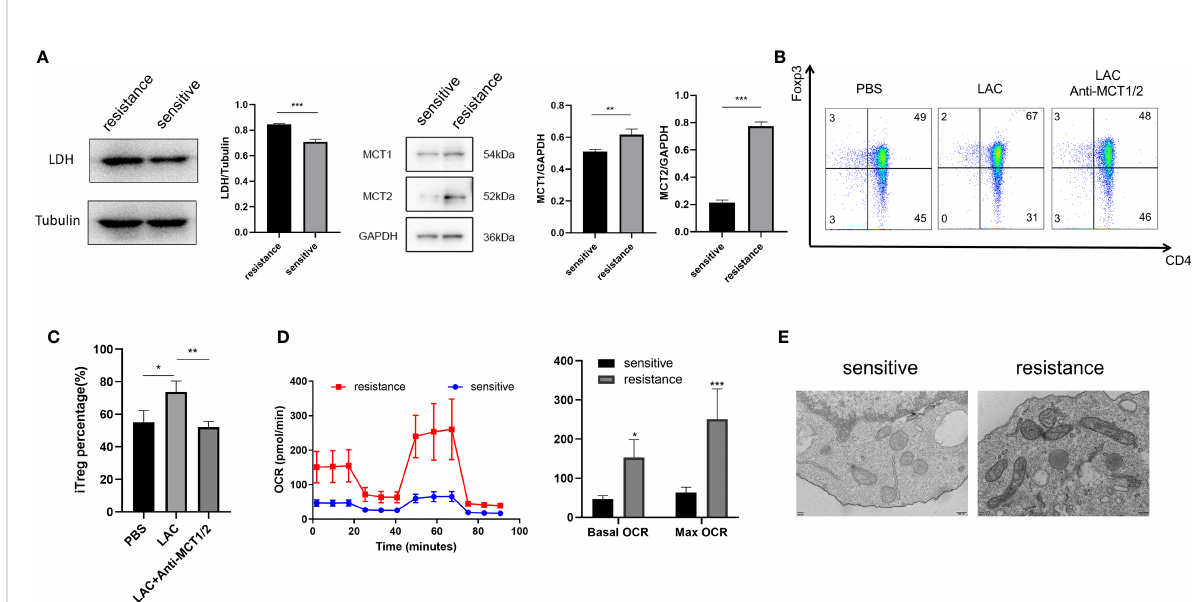
FIGURE 4 Foxp3 was upregulated in the iTregs of the resistant group in an MCT-dependent manner. (A) Representative blot plot for expression of LDH, MCT1, and MCT2 in both groups. Representative fl ow plot (B) for and the frequency (C) of Foxp3 expression in iTregs with the addition of lactate (10 mM) and inhibitors of MCT1 and MCT2 in resistance patients. (D) Oxygen consumption per unit time of two groups. (E) Representative plot for mitochondrial morphology observed through electron microscopy. The bar shows the mean ± SEM of the levels of indicated proteins. *p < 0.05; **p < 0.01;